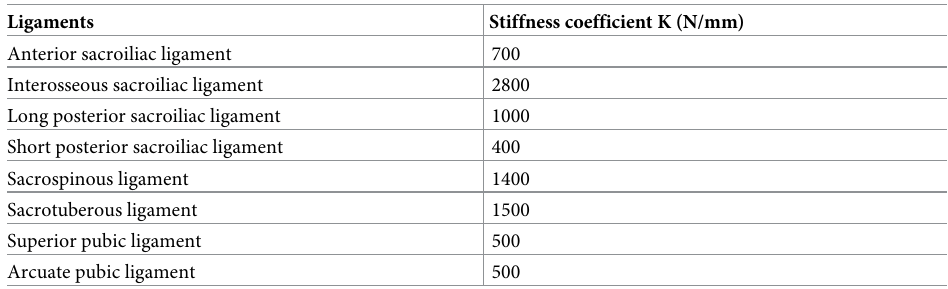
Table 2. Main ligament parameters of the pelvis [20,